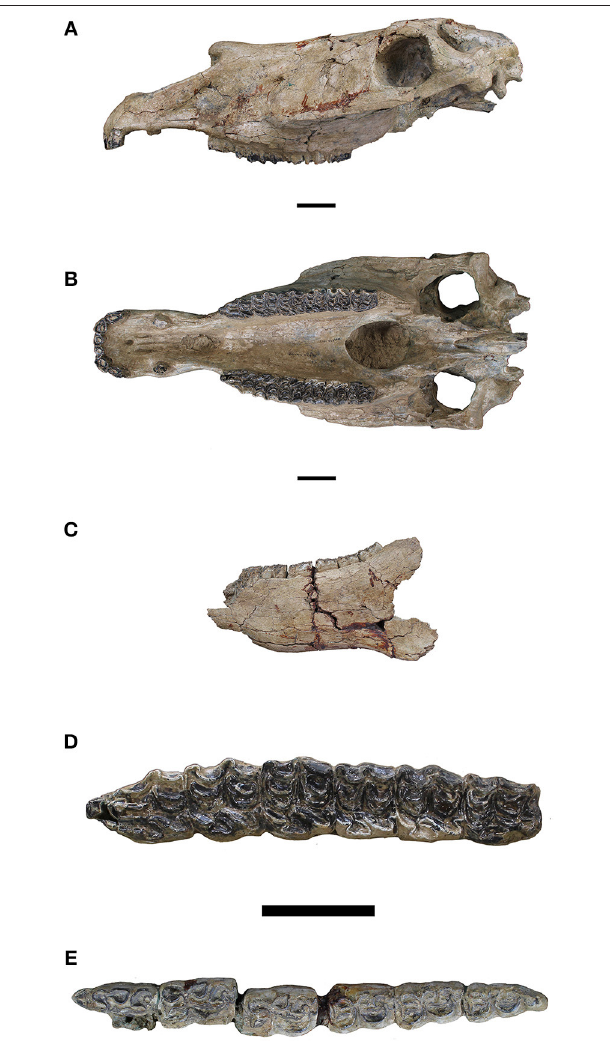
FIGURE 8 | Equus oldowayensis . (A) Skull in lateral view; (B) Skull in ventral view; (C) Mandible in lateral view; (D) Upper tooth row in occlusal view; (E) Lower tooth row in occlusal